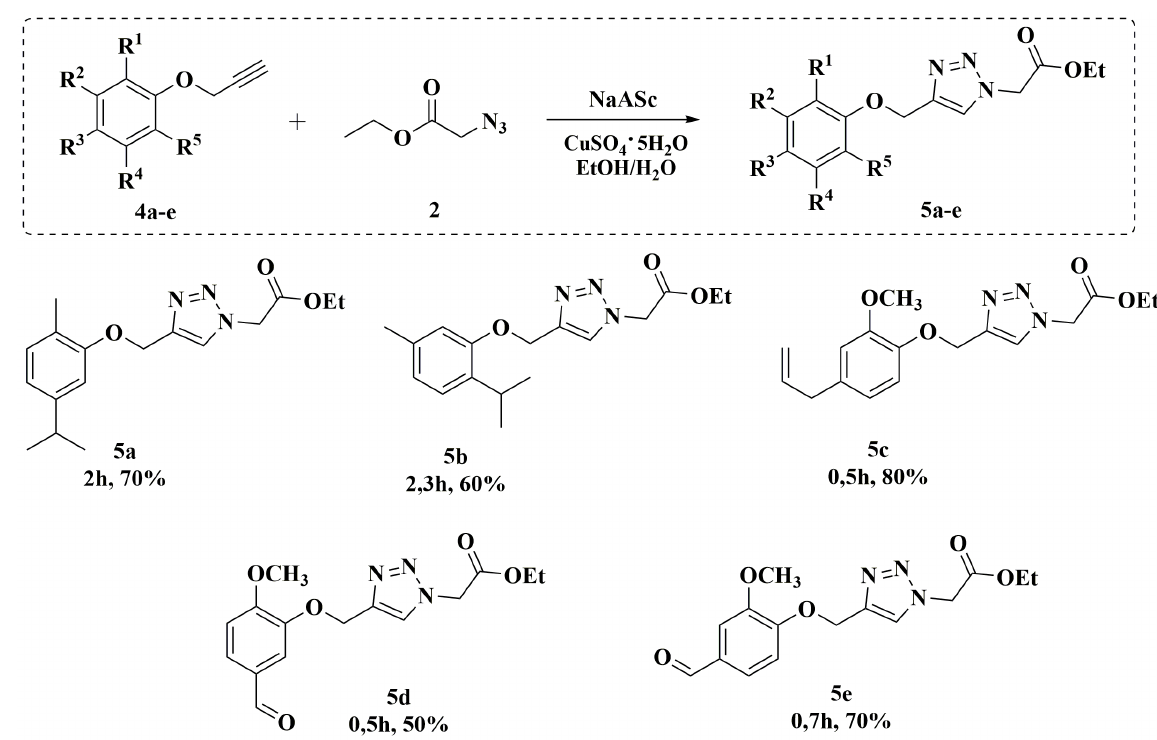
Figure 3. Derivatives of the new 1,4-disubstituted 1,2,3-triazoles semi-synthetic